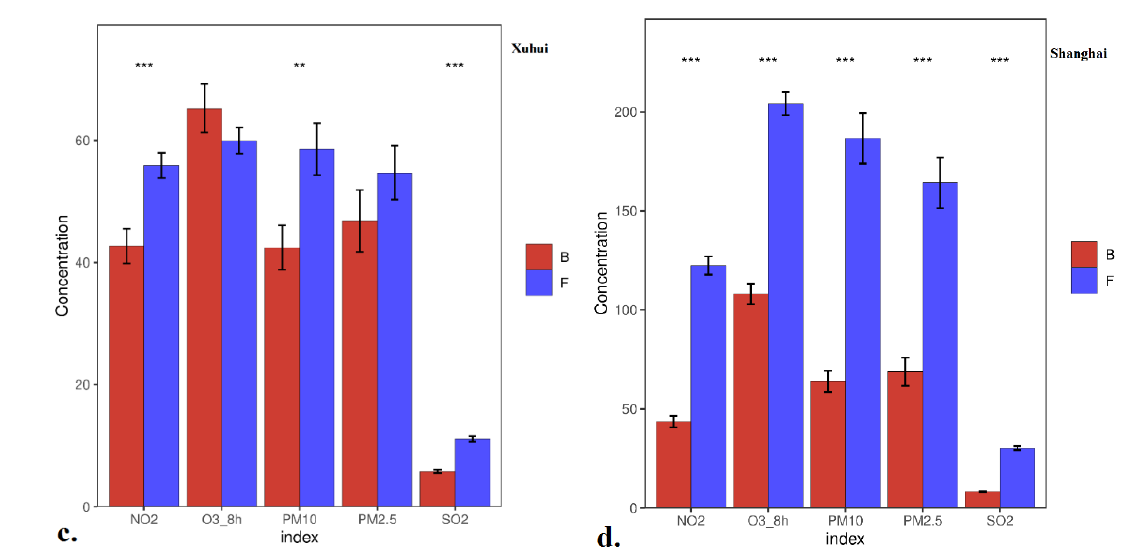
Figure 3. One-way ANOVA analysis for different parts and for all of Shanghai before and during COVID-19: during (B) and before (F) lockdown period. ( a – d ) represents concentrations of different pollutants, i.e., NO 2 , O 3 , PM 10 , PM 2.5 and SO 2 in Chongming, Jinshan, Xuhui as different functional areas and average values from the three functional areas of